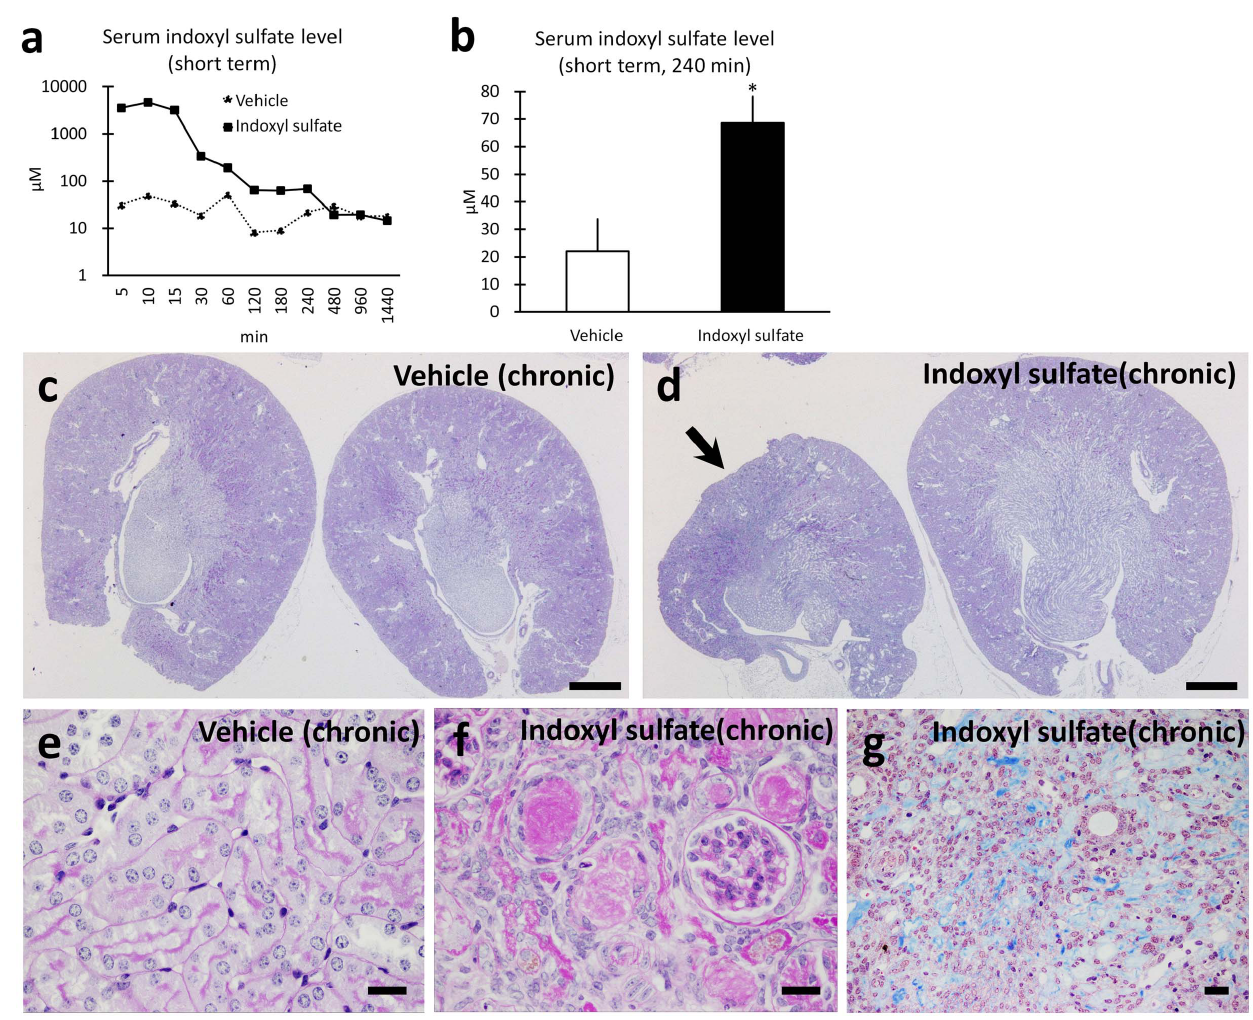
Figure 1. Indoxyl sulfate induced tubulointerstitial and vascular injuries in mouse kidneys. Serum indoxyl sulfate levels were measured following single dose exposure ( a and b ). C57BL/6 mice (800 mg/kg, i.p. given once). n=1 (time course, panel a ). n $ 7 (240 min, panel b ), mean 6 SD. Histopathology of FVB/N mouse kidneys following chronic exposure to vehicle or indoxyl sulfate, administered at 600 mg/kg/d i.p. for 8 w ( c – g ). In contrast to kidneys from vehicle-exposed mice ( c ), global renal atrophy was observed in 1 of 2 kidneys from an indoxyl sulfate-exposed mouse ( d , arrow). Bars=500 m m. Vehicle-treated mice manifested histologically unremarkable tubules stained with periodic acid Schiff ( e ). In the macroscopically atrophied kidneys in indoxyl sulfate-exposed mice, prominent tubulointerstitial injury with numerous, prominent protein casts within tubules and extensive tubular atrophy ( f ) and foci of interstitial fibrosis were observed with Masson trichrome staining ( g ). Bars=20 m m.